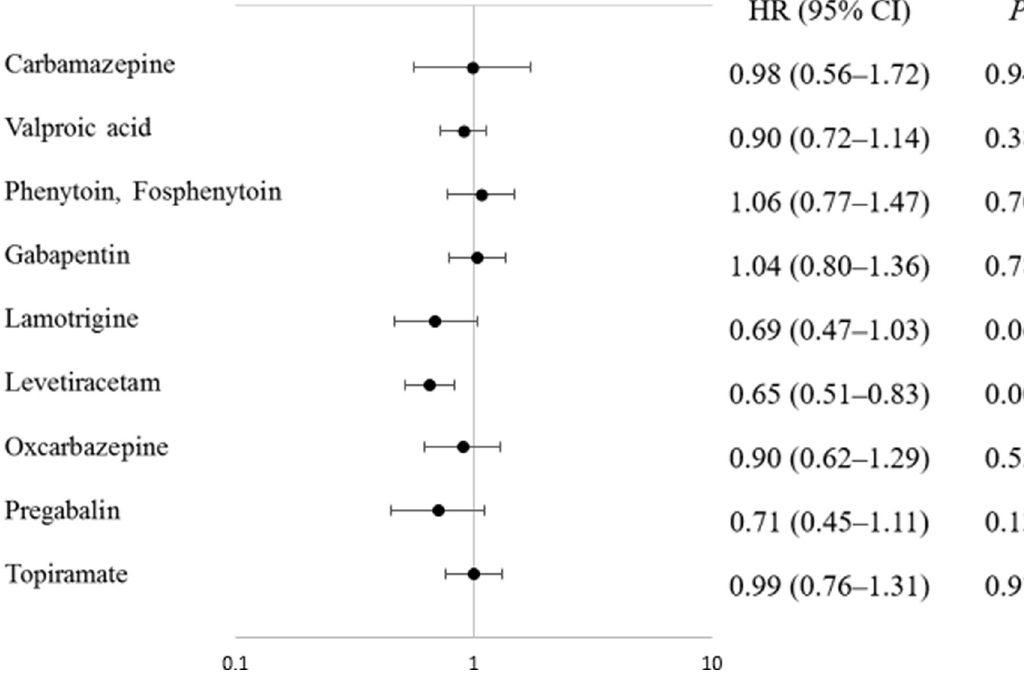
Fig 2. The Kaplan–Meier survival plot showing the overall survival (OS) duration. (a) The LEV-treated group (LEV; blue line) versus no LEV treatment (No LEV; green line). (b) The VPA-treated group (VPA; red line) versus no VPA treatment (No VPA; gray line). (c) The group treated with both LEV and VPA (both; black line) versus the LEV-treated group (blue line) or the VPA-treated group (red line). (d) Treatment with only LEV and VPA (only both; silver line) versus only LEV treatment (only LEV; azure line) or only VPA treatment (only VPA; orange line).